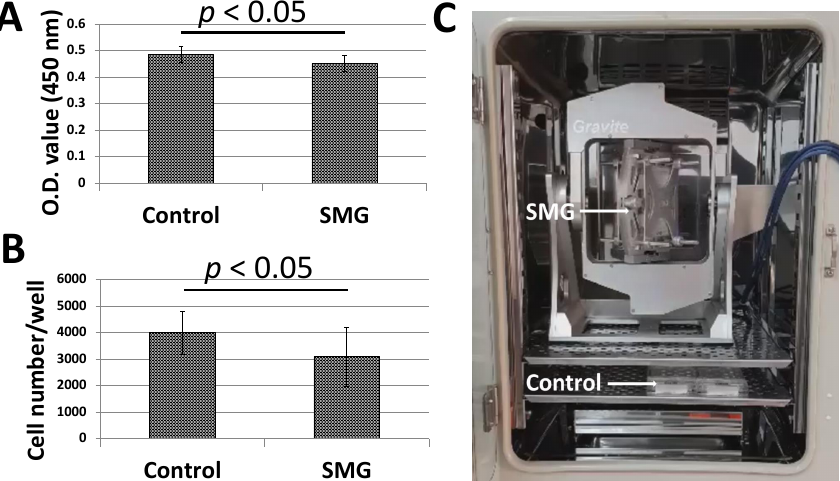
Figure 1. The proliferation of pGCs from the control and SMG groups. ( A ) pGC proliferation assessed by a WST-1 assay; ( B ) pGC density assessed by the cell cycle app. of a Cytell microscope; ( C ) Gravite operation in a CO 2